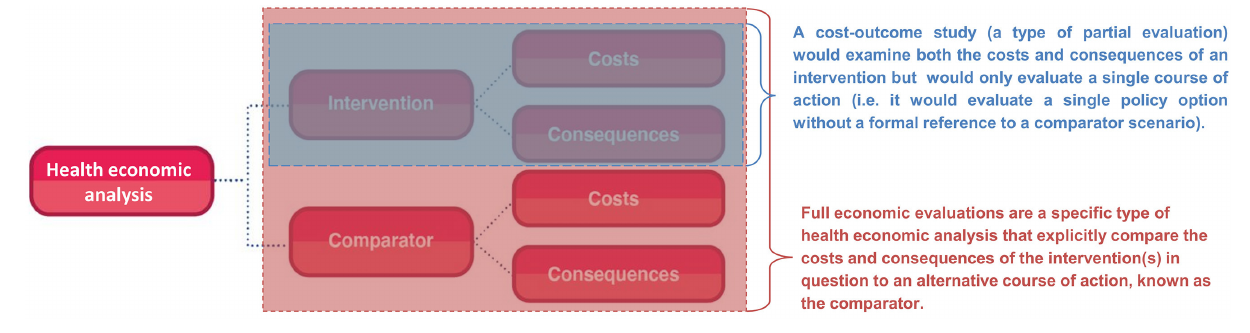
FIGURE 1 | The difference between full economic evaluations and cost-outcome partial evaluations.